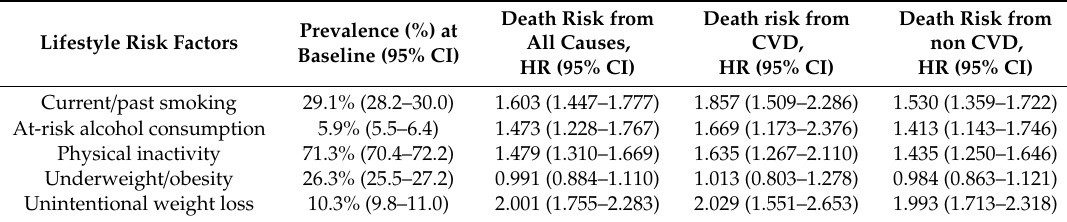
Table 3. Prevalence of lifestyle risk factors at baseline and hazard ratios of all-cause and CVD mortality during 10 years of follow-up.